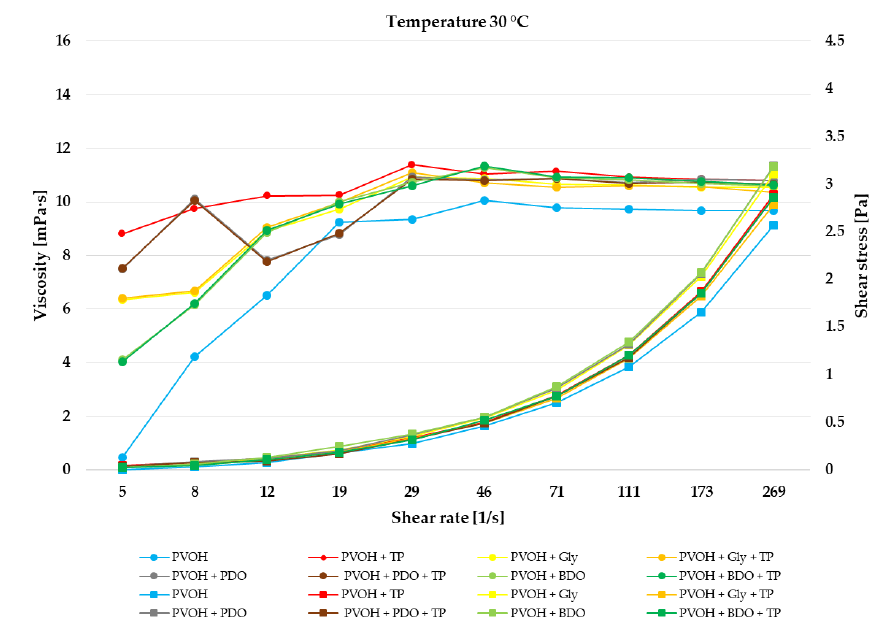
Figure 3. Shear viscosity and shear rate of biofilms at 30 °C temperature. The reported mean values with standard deviation (±) are available in Supplementary Material 2.